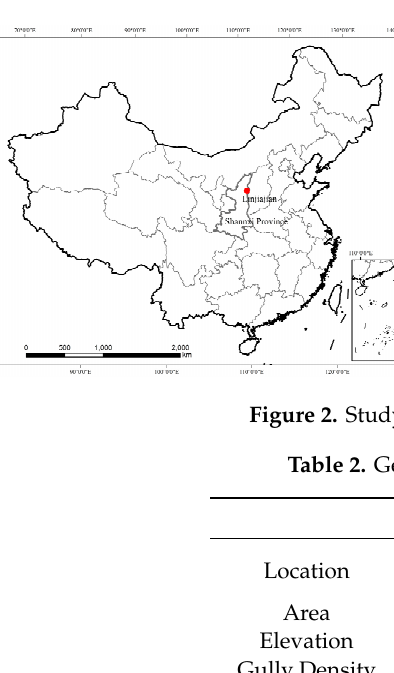
Table 2. Geography of Study Areas.